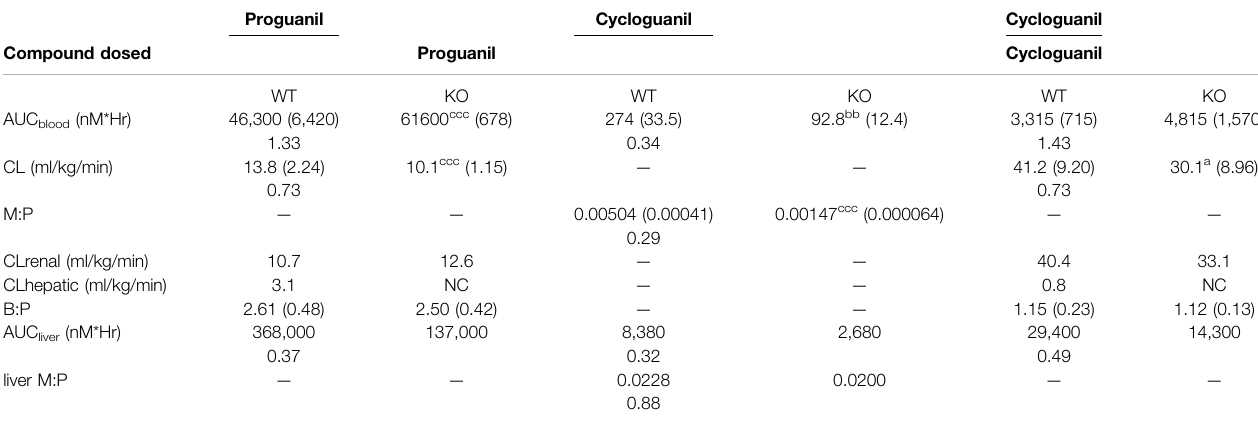
TABLE1|EffectofOctknockoutonthepharmacokineticsofproguanilandcycloguanilfollowingIVadministrationofbothproguanilandcycloguanil. Shown are dose-normalized blood and liver pharmacokinetic parameters for mice ( n (cid:2) 5 or 5/timepoint) administered proguanil 2, 10 or 30 mg/kg or cycloguanil 2 mg/kg. Data presented as mean ± SD. Ratio of KO/WT are reported below mean values with signi fi cant